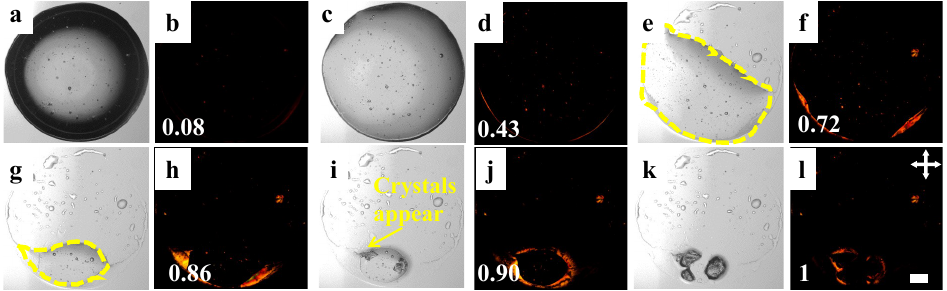
Figure 2. Time-lapse images of drying LC+PBS drop at an initial concentration ( φ PBS ) of 0.75 × . The timestamps ( t ) are calculated as the ratio of the instantaneous time and the total drying time ( t d ), shown at the bottom left of each image. The different stages of the drying process are imaged under bright-field ( a , c , e , g , i , k ) and crossed polarizing configurations (crossed double arrows). The LC droplets are shown with the bright patches in the crossed configurations ( b , d , f , h , j , l ). The white color in the right corner is a scale bar representing a length of 0.20